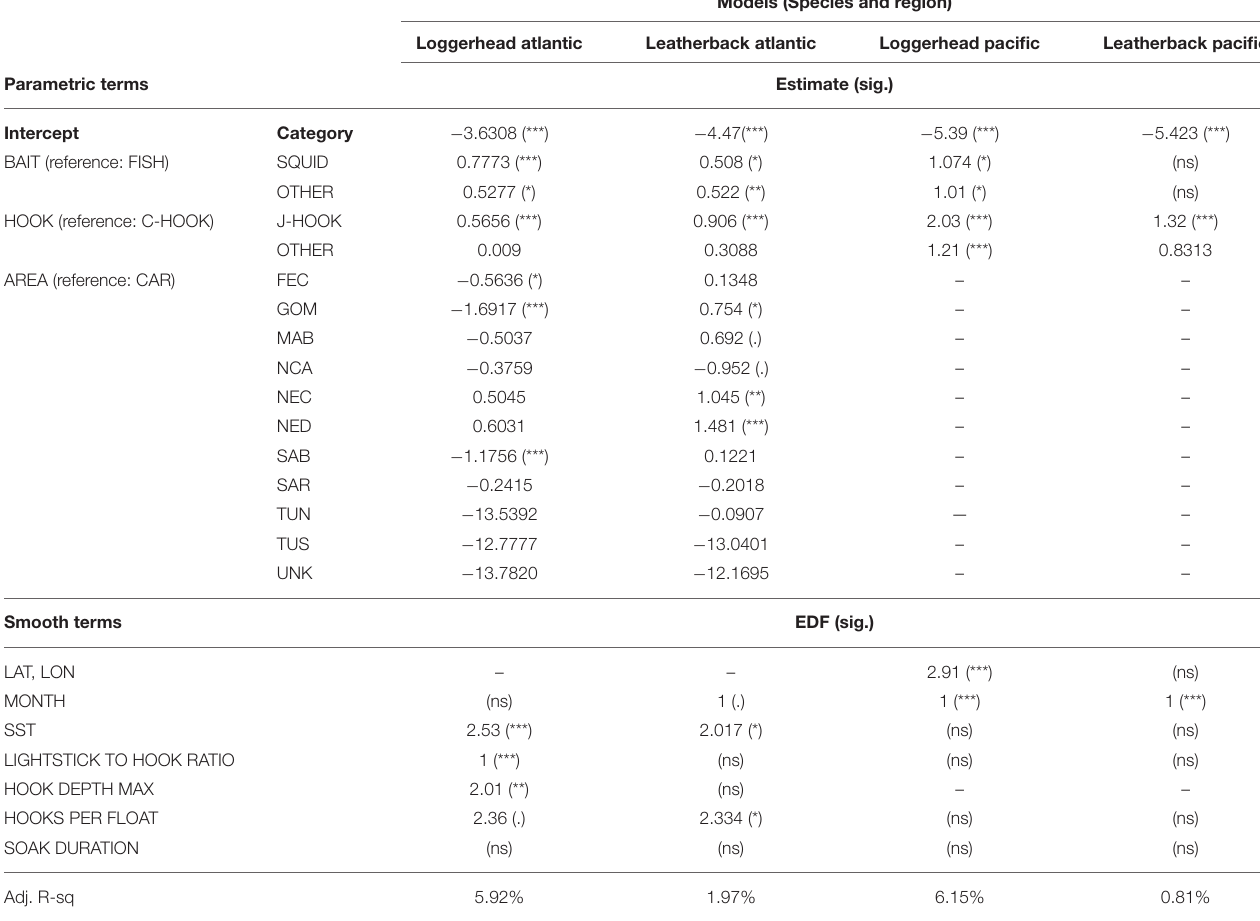
TABLE 4 | GAMM selection parameters and